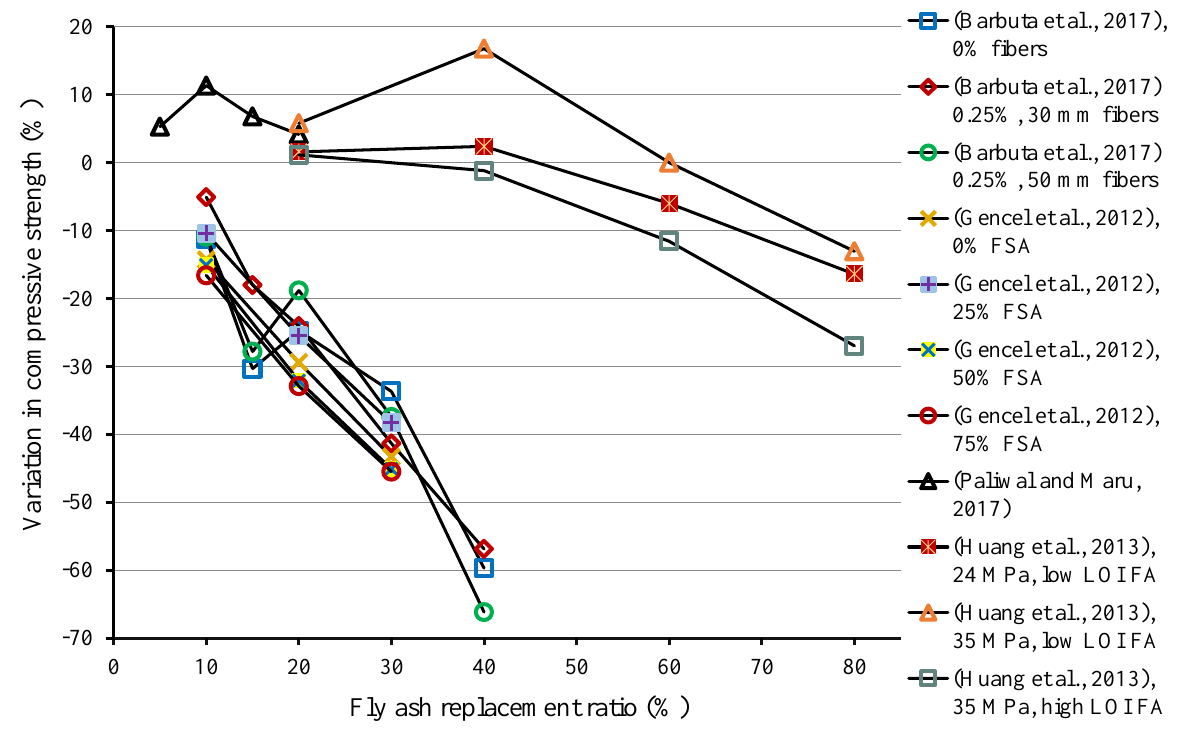
Figure 2. Influence of fly ash as cement replacement on 28-days compressive strength of composites. FSA: ferrochromium slag aggregate [107 – 109, 115].